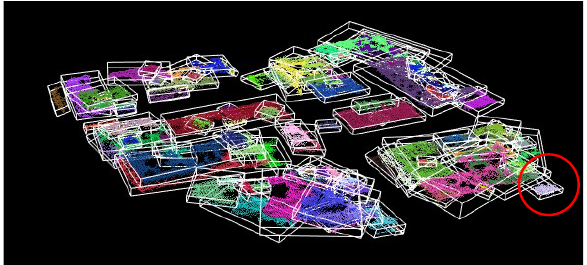
Figure 6. The detected roof elements presented in random colour, surrounded by the OBB and a false-detection presented in the red